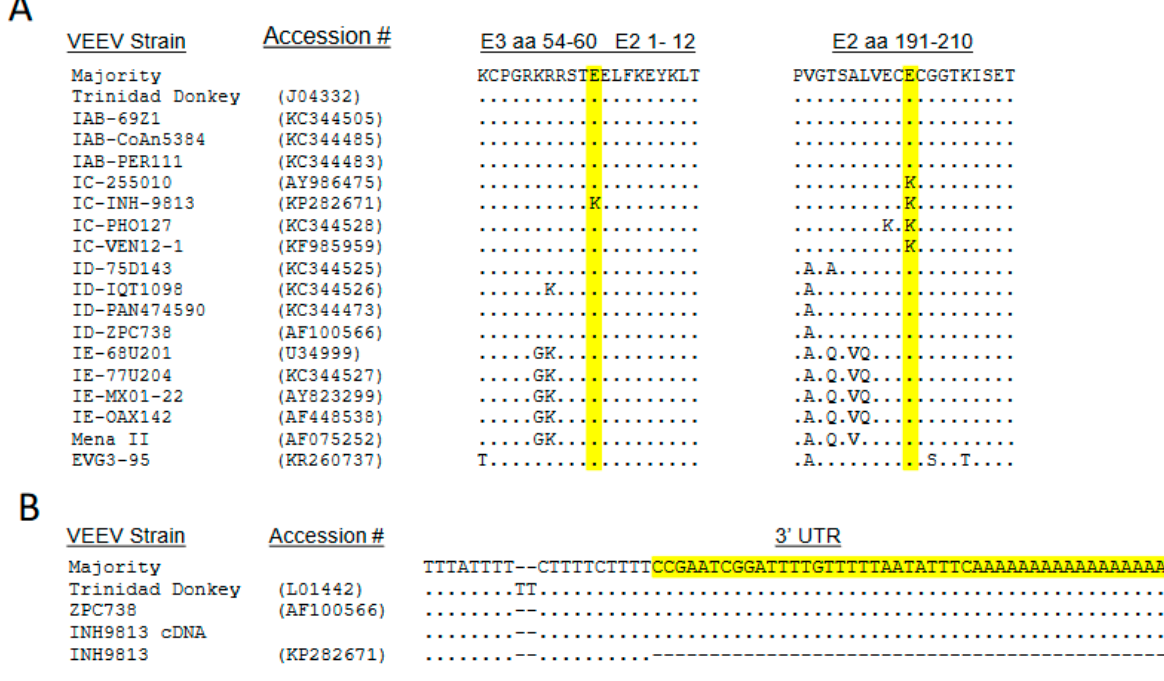
Figure 1. ( A ) Alignment of selected regions of the E3/E2 proteins of various VEEV epizootic and enzootic strains highlighting the E2 3 and E2 201 positive charge residues in the sequence of VEEV INH-9813. ( B ) Alignment of 3 ′ UTR sequences of various VEEV isolates and INH9813. The yellow highlighted sequence was added to the INH9813 cDNA clone.